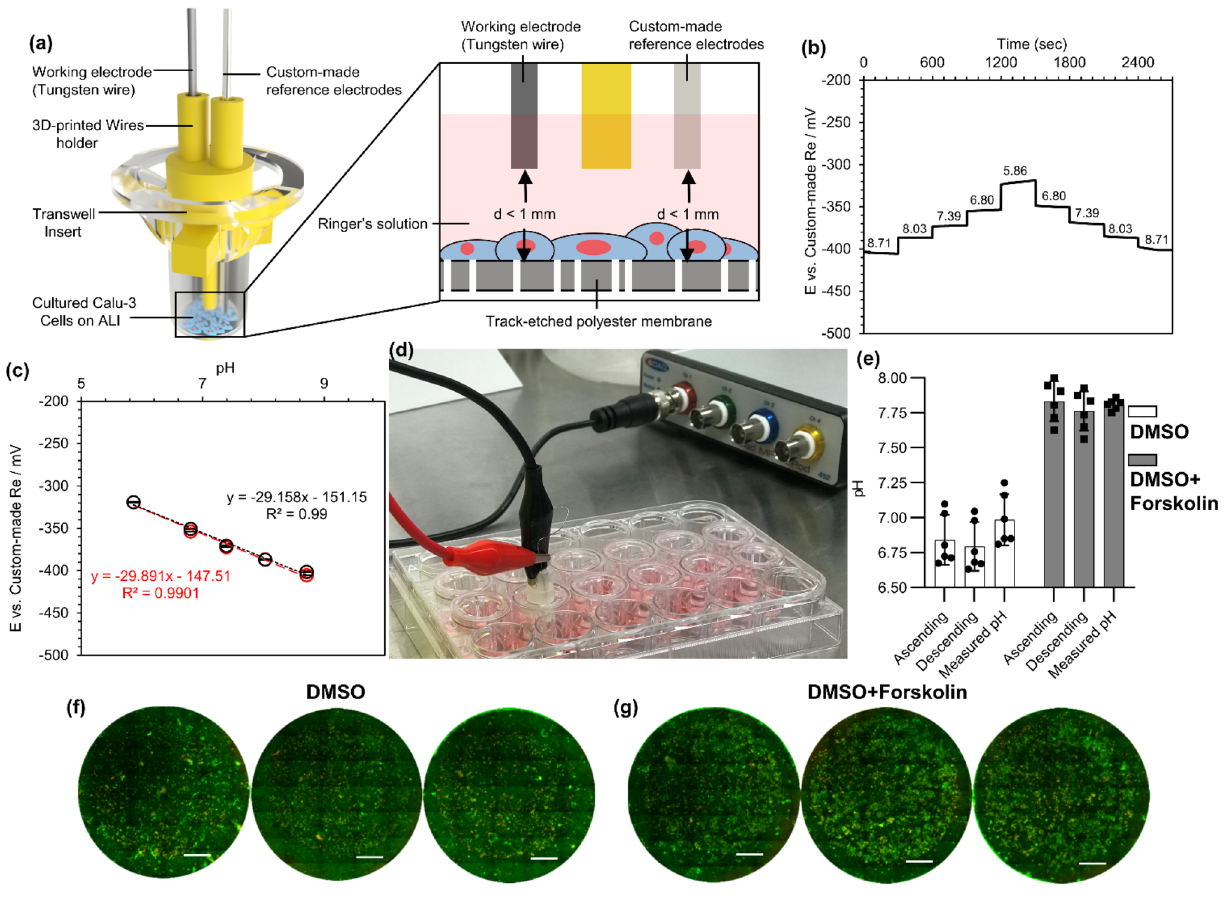
Figure 8. ( a ) a schematic of the 3D-printed holder for bringing wire sensors in tough with the apical testing solution with a close-up view of the micro-wires at ALI, ( b ) real-time response of 5-min bleached silver wires versus a tungsten wire in home-made Ringer’s solution without any buffer with various pH after being conditioned in PBS for 1 day, ( c ) the calibration curve for the sensor (decrease in pH is shown by red colors and increase in pH is indicated by black color.), ( d ) the experimental setup for measuring pH of the apical solution in Transwell insert after being treated by DMSO or DMSO + Forskolin, ( e ) a comparison between the measured pH by the wire sensor and a commercial pH electrode (apical solutions were collected and pH of them were measured later by the commercial pH meter), and in vitro viability assay of Calu-3 cells treated by ( f ) DMSO or ( g ) DMSO + Forskolin. Scale bars are 1